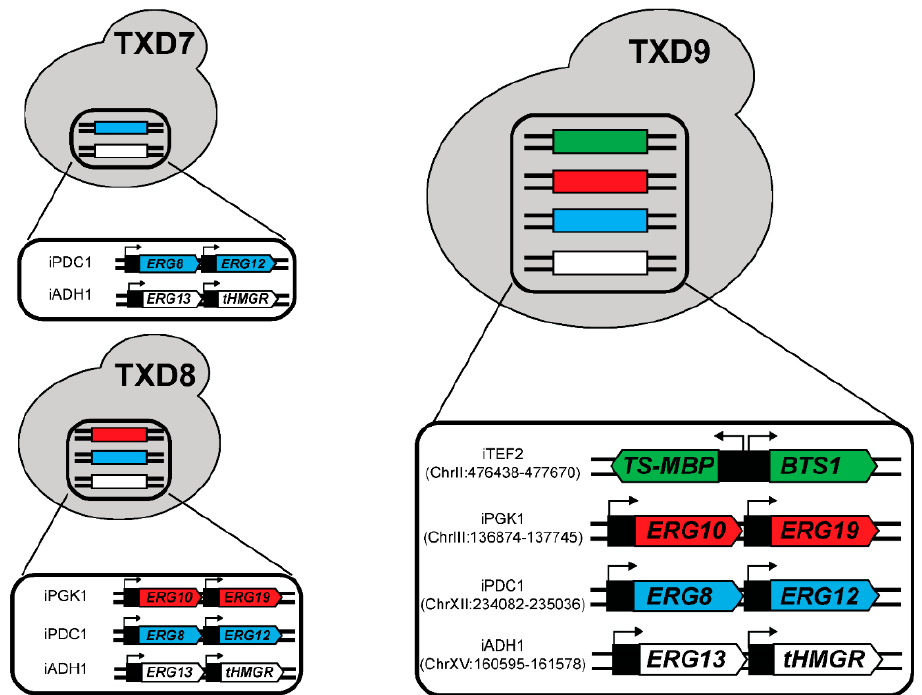
Figure 6. Schematic diagram of the MVA pathway genes, BTS1 , and TS-MBP integration into yeast genome to create TXD7, TXD8, and TXD9. The label on the left indicates the intergenic loci of respective genes, e.g., iTEF2 means intergenic locus flanking the TEF2 gene. The location of the loci in the genome was also indicated here. To produce taxadiene, a pESC-Ura plasmid containing TS-MBP and BTS1 was transformed into TXD7 and TXD8. TXD9 is capable to produce taxadiene without plasmid. The promoters that were used were listed in Table